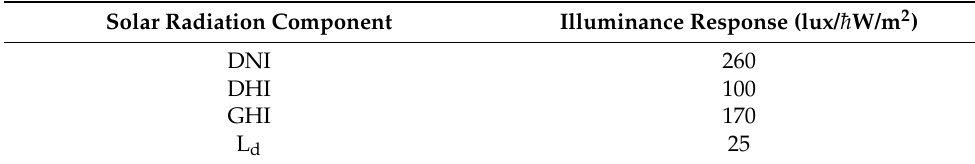
Figure 12. Indoor illuminance response of a passive solar building office space to various solar radiation components. Table 4. Daylight illuminance response of a passive solar building office space to solar radiation